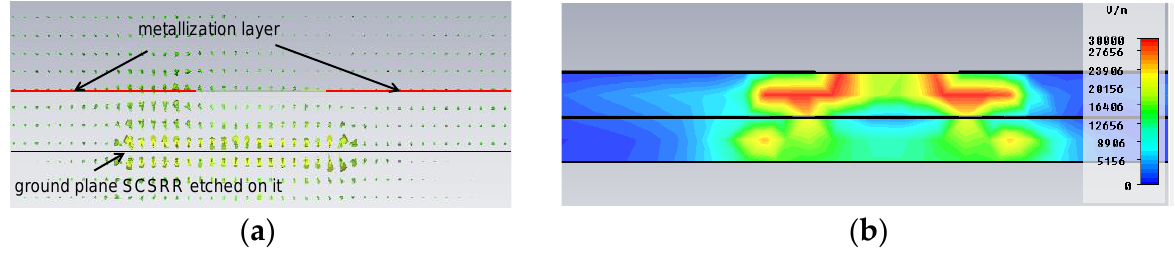
metallization layer Figure 3. E-field SCSRR excitation. ( a ) Vector plot. ( b ) Absolute E-field values. Figure 3. E-field SCSRR excitation. ( a ) Vector plot. ( b ) Absolute E-field